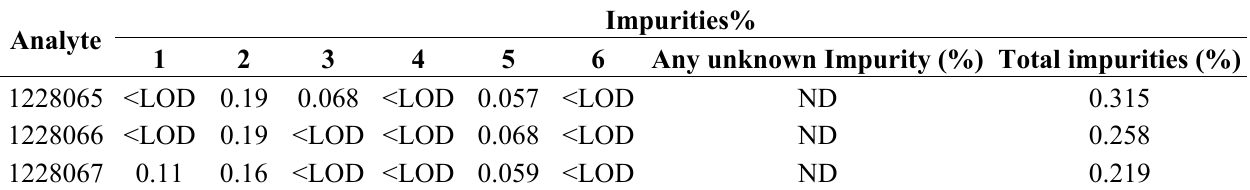
Table 7. Analysis of related substances of micafungin sodium in bulk samples by high performance liquid chromatography